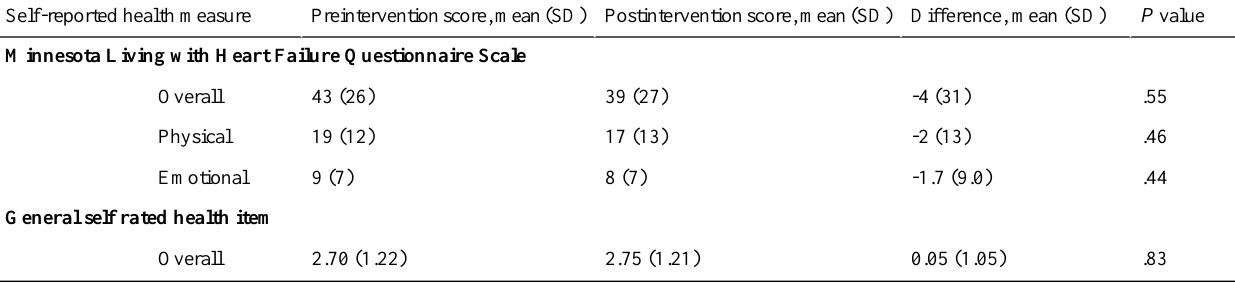
P valueDifference, mean (SD)Postintervention score, mean (SD)Preintervention score, mean (SD)Self-reported health measure